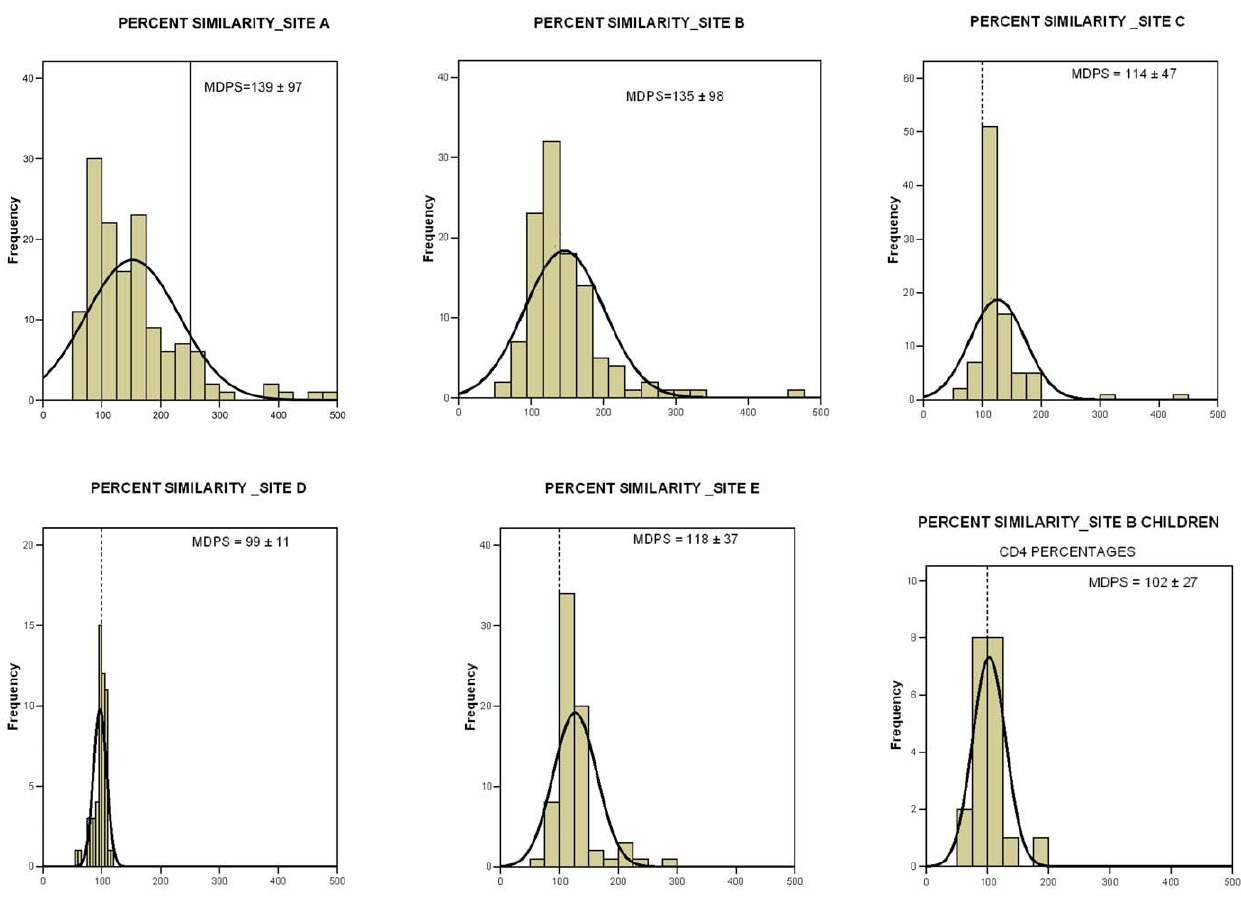
Figure 2. Percent similarity histogram of each site evaluation. Percent similarity values on absolute CD4 counts (Site A–E) or relative CD4 (Site B-Children) were plotted per ranges according to frequency in the respective site. Outlier values corresponding to percent similarity values above 500% were removed: 5 data sets were removed from site A (562, 731, 755, 944, 1572); 2 data sets from site B (704, 1675); and 1 data set from site C (765). For each site, median percent similarity (MDPS) 6 standard deviation were